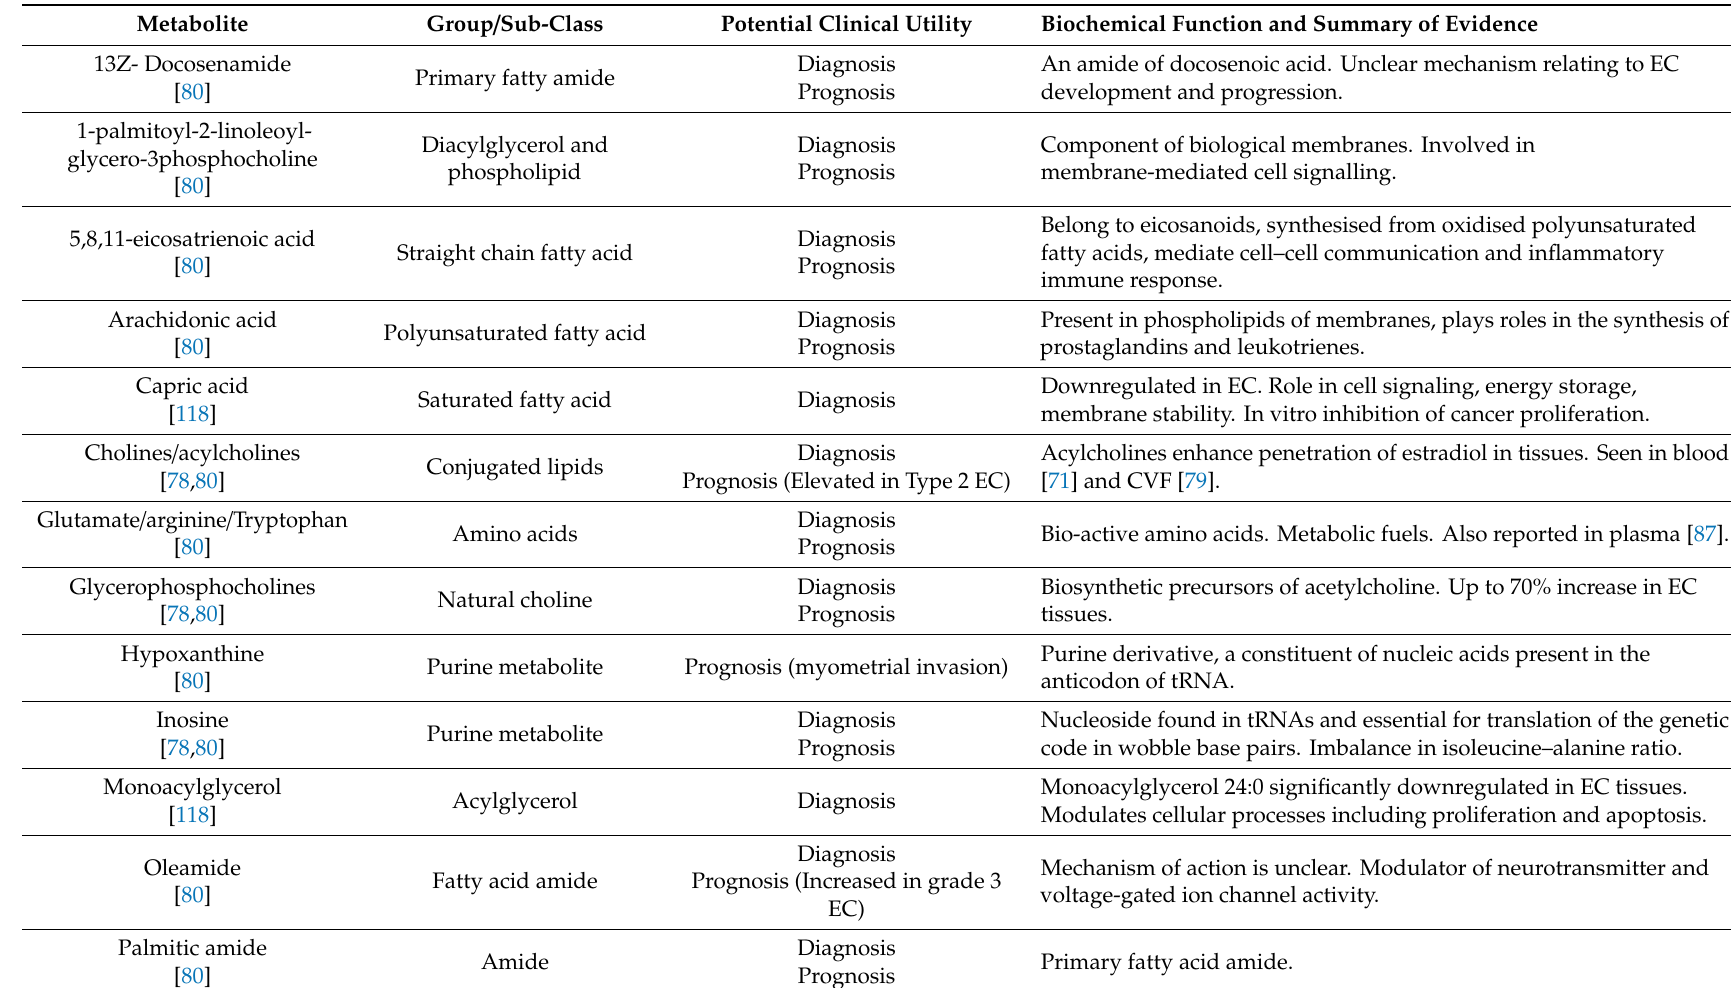
Table 2. Most promising tissue-based EC metabolomic biomarker candidates and their